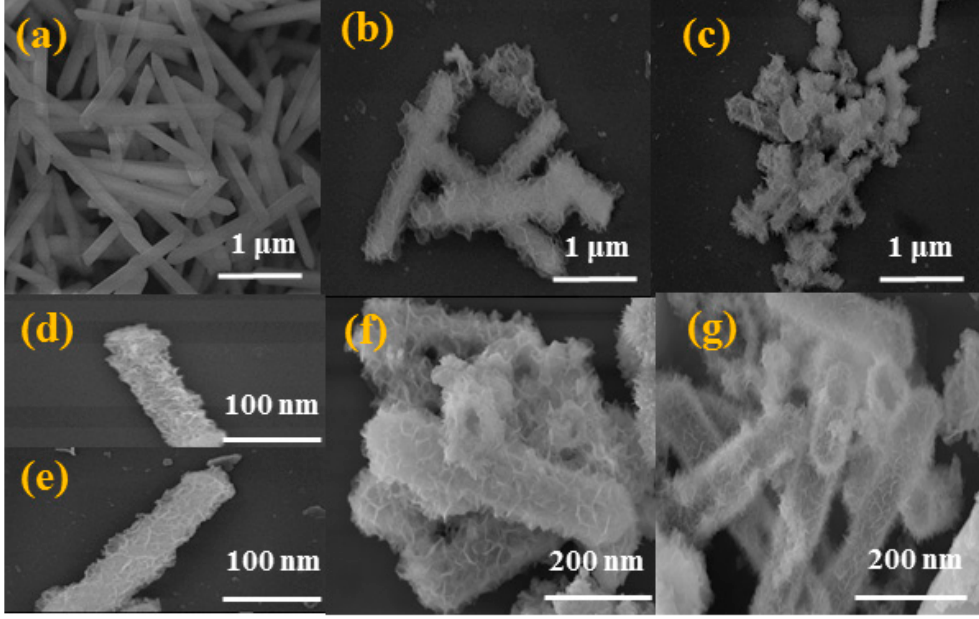
Figure 4. SEM images of MIL-88A ( a ), NiFeCe-LDH ( b , d ), NiFeTb-LDH ( c , e ), NiFeCe-LDH/MoS 2 ( f ) and NiFeTb-LDH/MoS 2 ( g ).